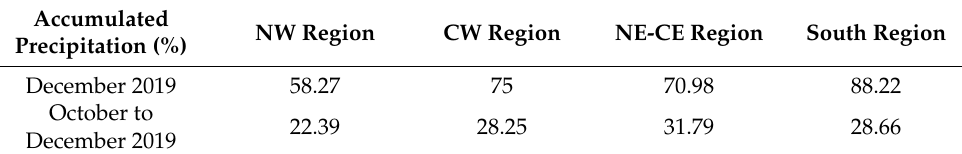
Figure 5. Daily mean precipitation from October to December 2019 (bars) and climatological daily mean precipitation over 4 regions of Portugal for 1980–2019 (lines) ( a – d ) and the daily mean accumulated precipitation from October to December 2019 and the monthly accumulated climatological precipitation for 1980–2019 ( e ). Table 1. Percentage of the precipitation from 16 to 22 December with regards to mean precipitation accumulated for December 2019, and from October to December